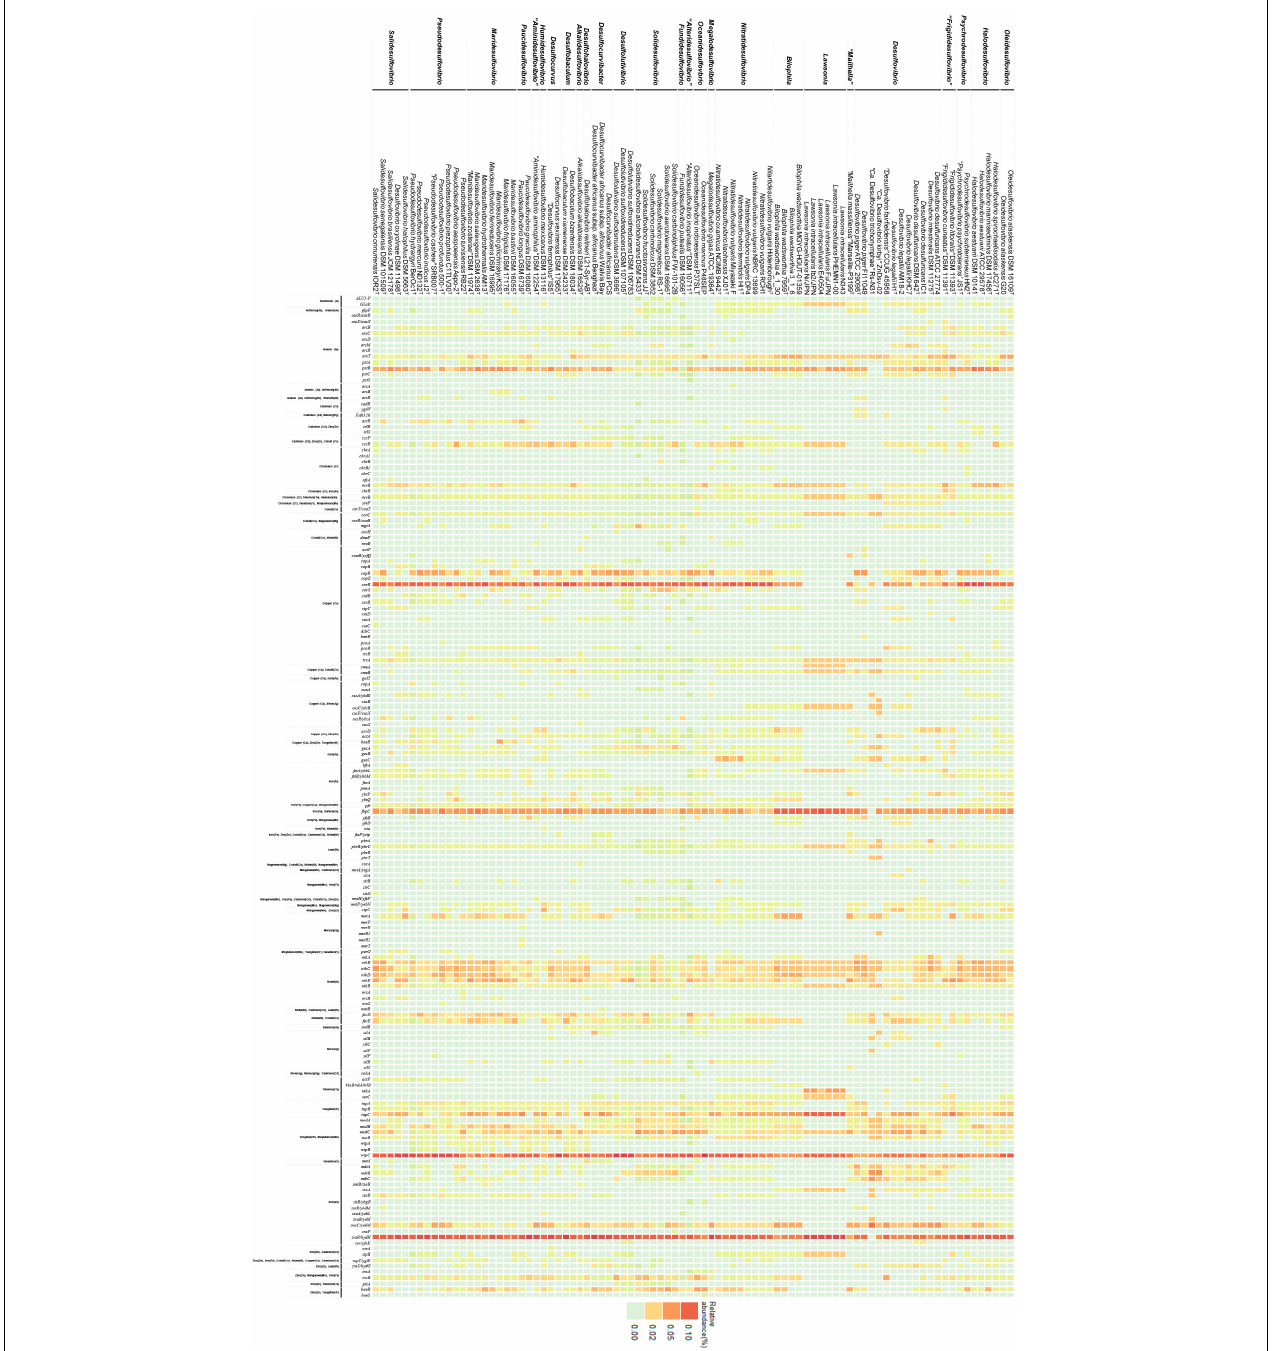
FIGURE 5 | Heatmap of metal related genes. This figure verifies that there is a distinguishable difference in pattern of metal resistance related genes between each group.